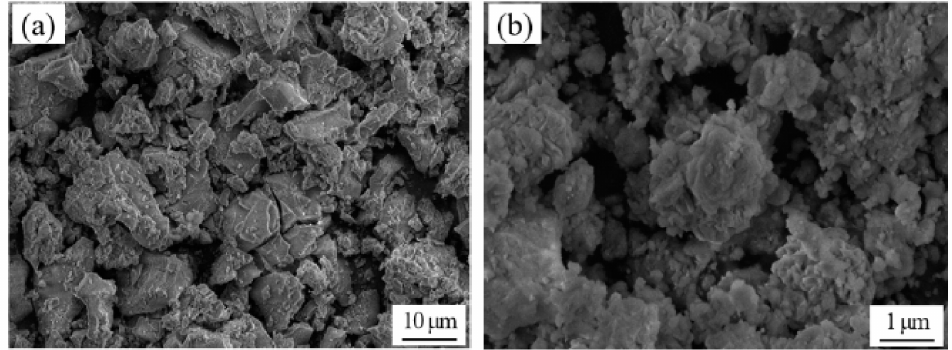
Figure 4. SEM images of the 50 wt.%Al-50 wt.%GIS (6:3:1) reaction product at ( a ) 1000 × and ( b )10,000 × .